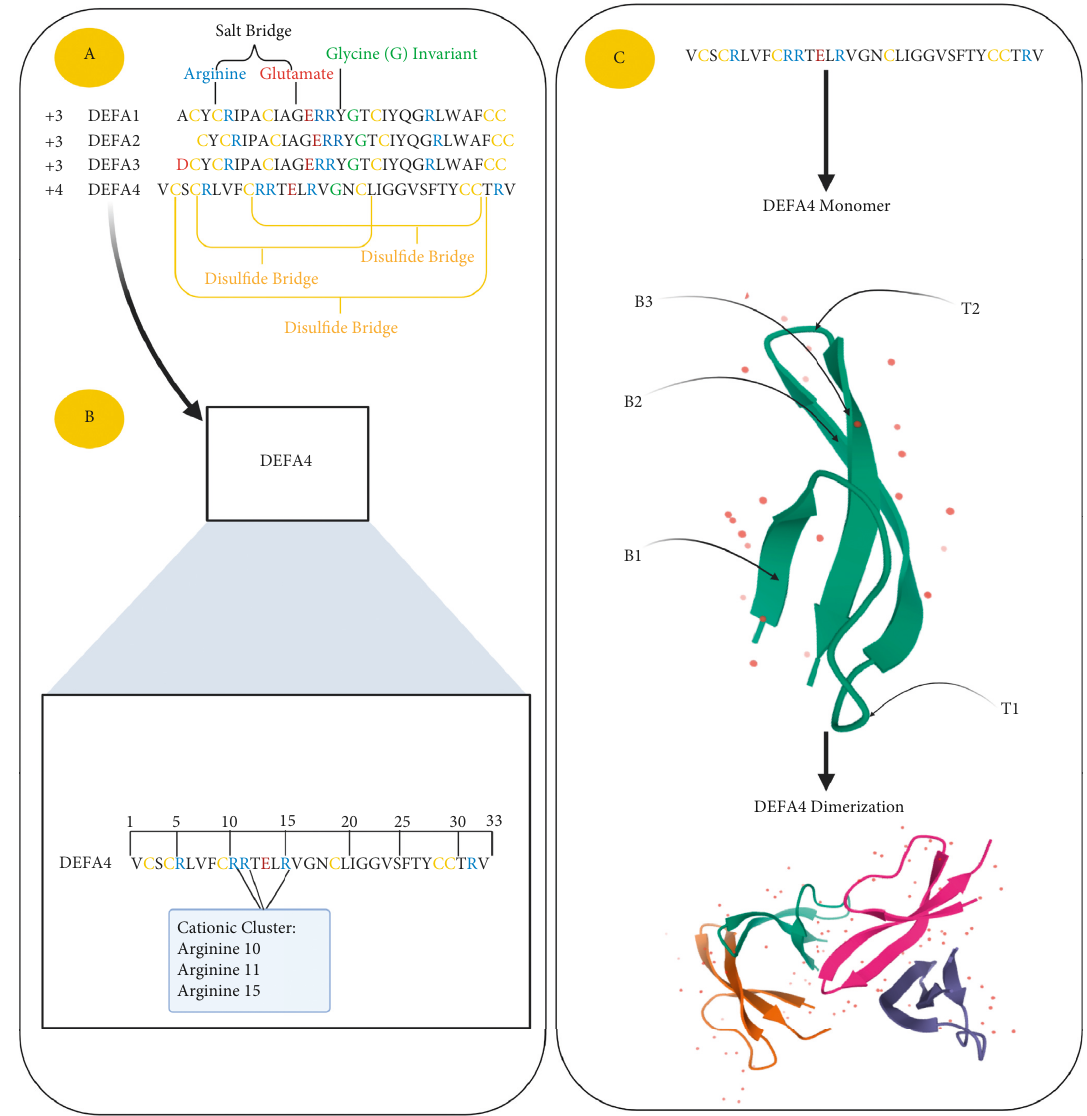
Figure 1: This figure shows the structure-related DEFA4 properties. Created with BioRender.com. (a) Alignments of the amino acid sequences that show conserved residues: 6 Cysteine residues (C) are shown in yellow; Glycine (G) is colored in green, Arginine (R) is located after the second Cysteine, Glutamic acid (E). Positively-charged residues are colored in blue, negatively-charged residues are colored in red. Relative to DEFA1–3 (+3), DEFA4 is the higher positive charge of (+4). This figure also shows the bonds that stabilize the α -defensins tertiary structure, 3 disulfide bridges between 6 conserved (C) and one salt bridge formed by the side chains of R and (E). (b) Three clustered cationic residues of Arginine (Arg10, Arg11, Arg15). (c) DEFA4 consists of three beta-sheets (B) arranged into an antiparallel structure. B1and B2 are connected by the long loop (T1), and beta-hairpin (T2) is formed by B2 and B3. DEFA4 forms homodimers